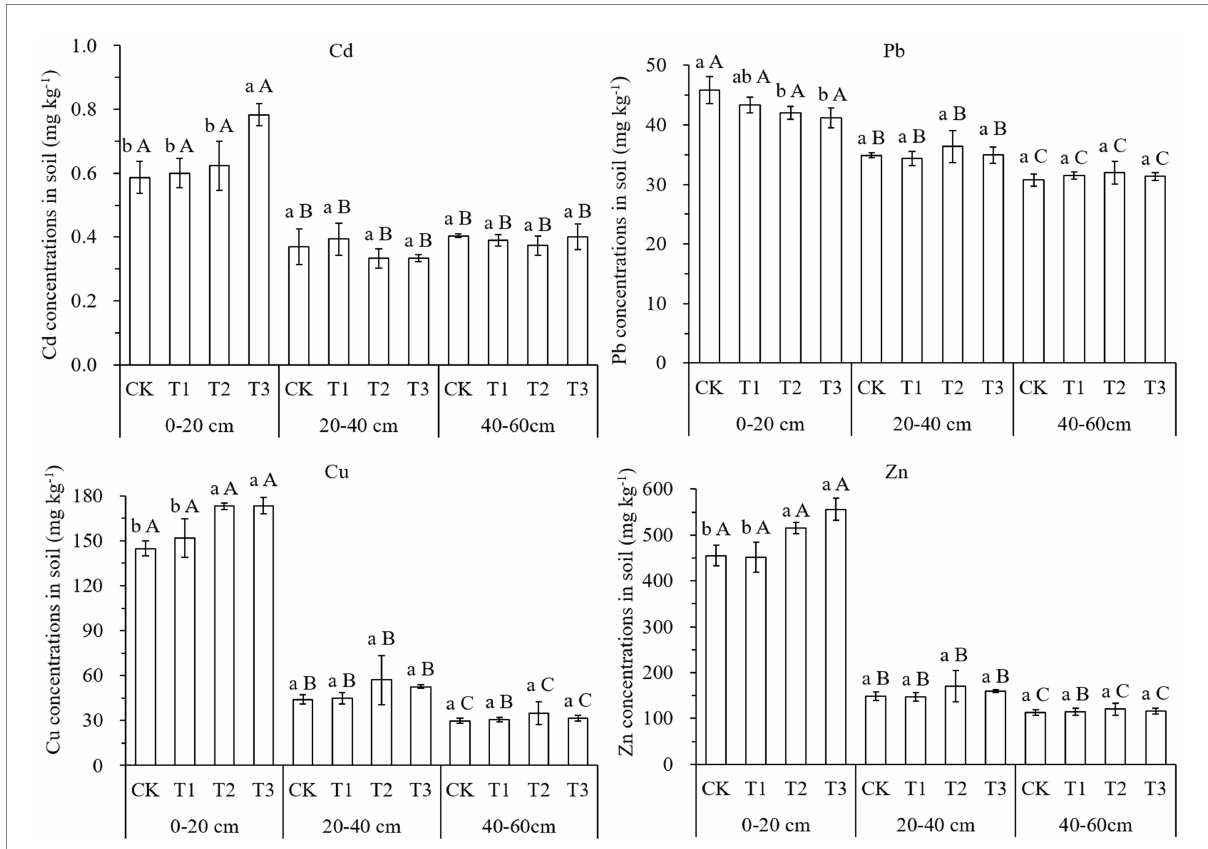
FIGURE 1 Effects of compost application on heavy metal concentrations in soil (mean ± S.D., n = 3). CK, T1, T2, and T3 mean compost application at rates of 0, 15, 30, and 45 t ha − 1 , respectively. 0–20, 20–40, and 40–60 cm are the depths of soil samples that were taken in the profile. The different lowercase letters indicate significant differences ( p < 0.05) between treatments in each layer, while different capital letters indicate significant differences ( p < 0.05) between soil layers in each